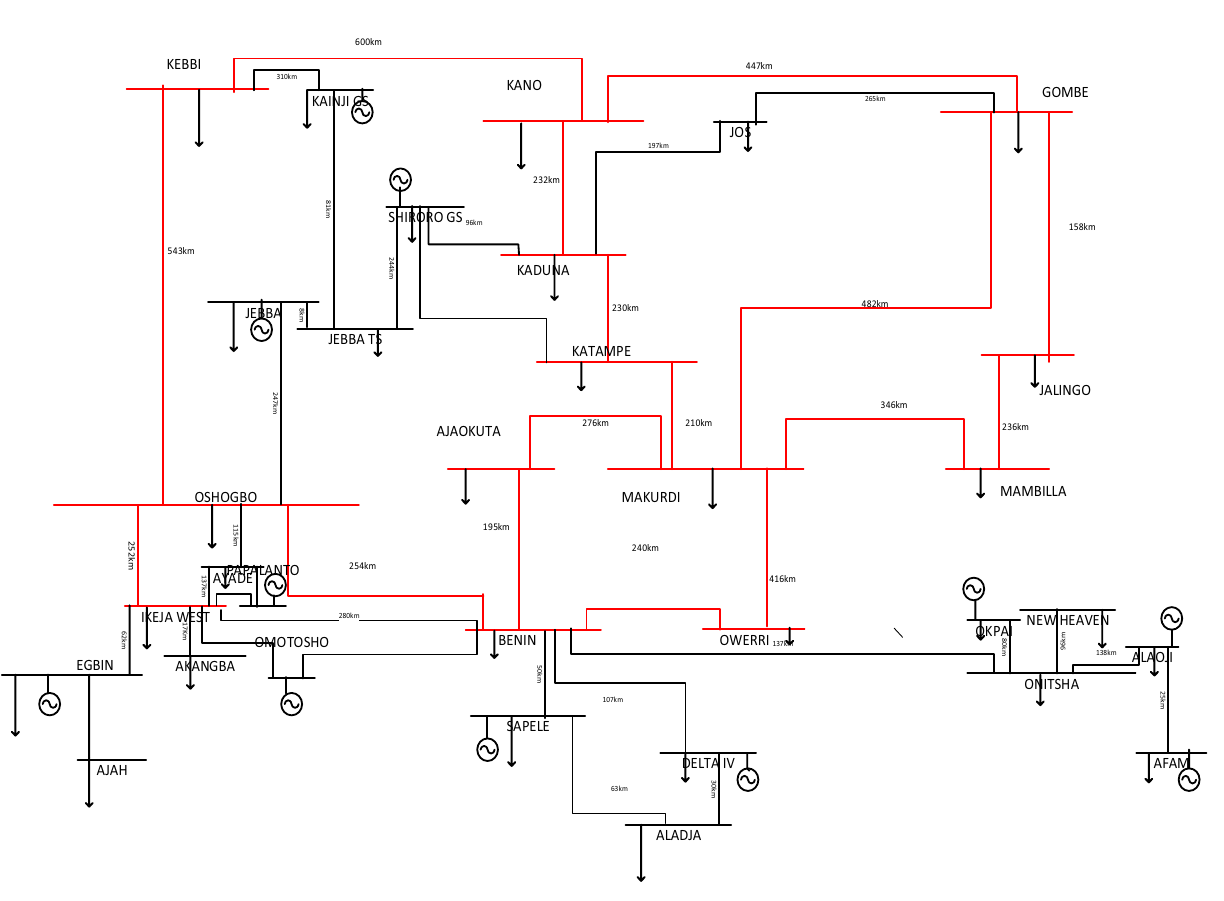
Fig. 3 Single line diagram of the integrated 750-kV Nigerian transmission Super